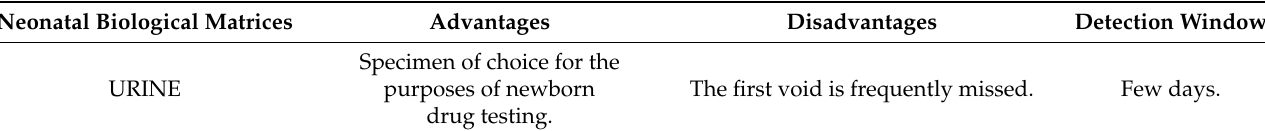
Table 2. The properties of neonatal biological matrices